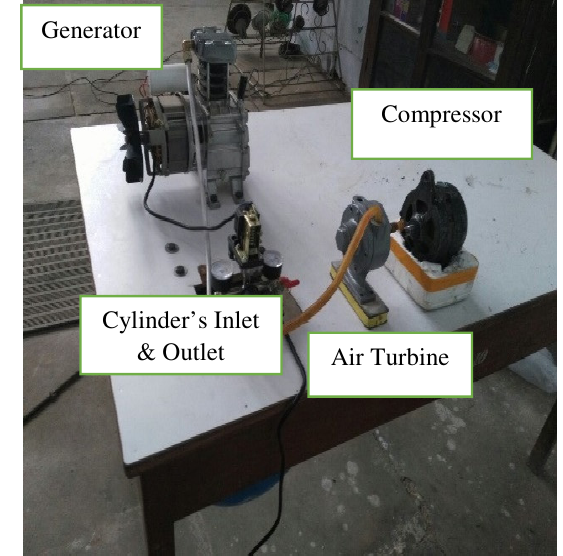
FIG.6 MODEL OF UPS USING CAES FROM